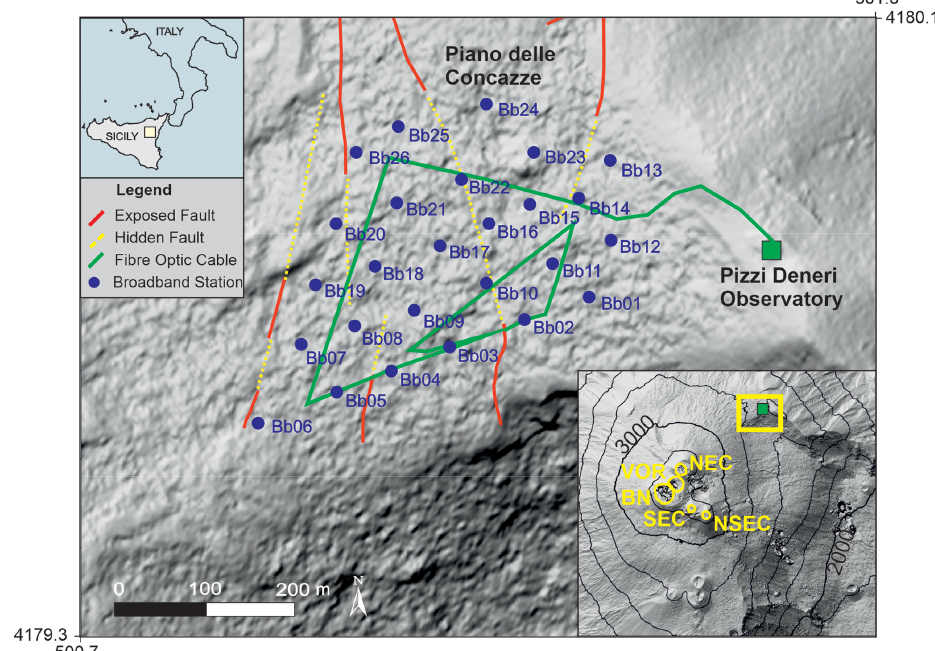
Figure 1. Digital terrain model of Piano delle Concazze on the north-eastern flank of the Etna volcano (Palaseanu-Lovejoy et al., 2020) with the dense broadband seismic array (26 stations; Bb01–Bb26) and distributed acoustic sensing (DAS) cable layout. The DAS cable geometry is designed in order to record dynamic strain changes along several directions. No data were recorded by station Bb05 because of a technical problem. The DAS interrogator was hosted inside the Pizzi Deneri Observatory, which is about 2km away from the five summit craters (North East: NEC; Voragine: VOR; Bocca Nuova: BN; South East: SEC; New South East: NSEC). The investigated area, which is almost flat, is crossed by a sub-vertical fault system (redrawn following Azzaro et al., 2012). Geographic coordinates (in kilometres) are in the UTM33S